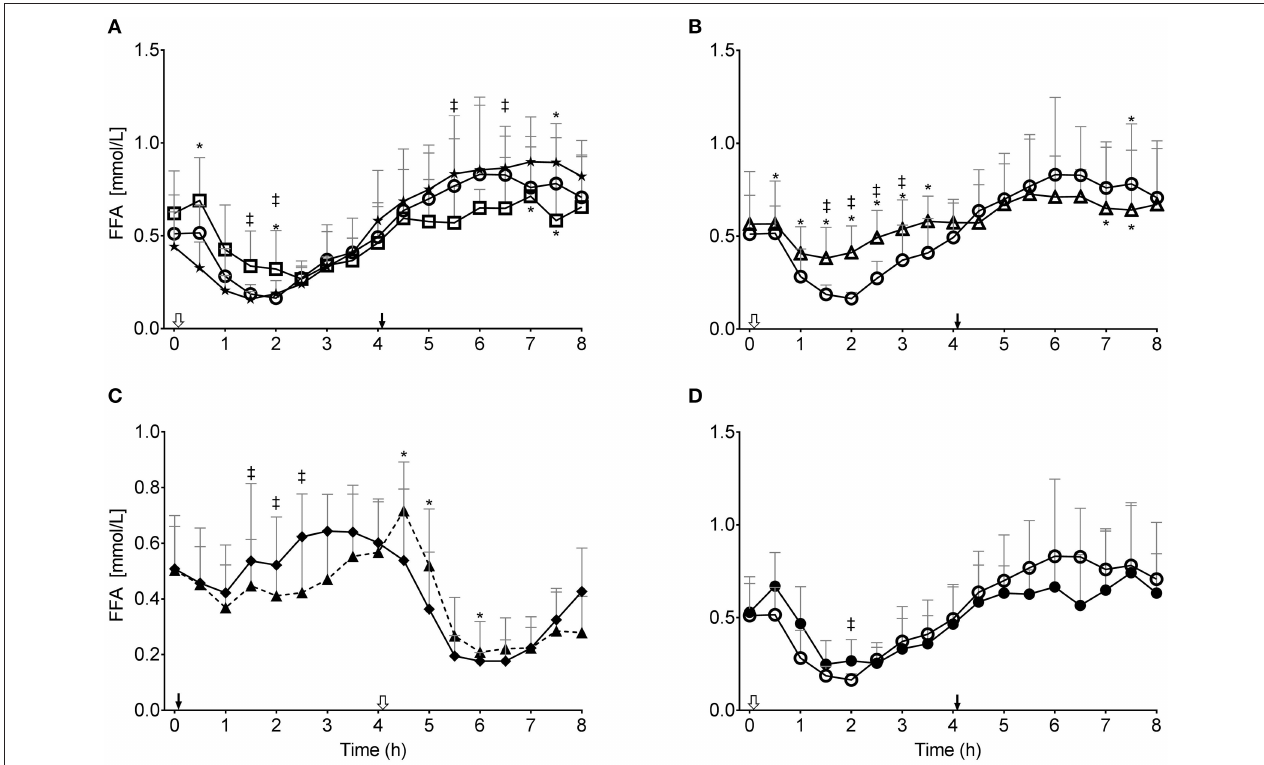
FIGURE 5 | Plasma free fatty acid (FFA) concentration during the tests: (A) without consuming kMCT (CTL, ⋆ ) or after 10g or 20g of kMCT (kMCT10, ; kMCT20, 2 ); (B) after 10g of kMCT with a carbohydrate-rich (kMCT0, ) or low carbohydrate (kMCT10LC, 1 ) meal; (C) after no meal or kMCT at T0 but a meal at T4 (MS-CTL; (cid:7) –– (cid:7) ) or no meal at T0 but a meal plus kMCT10 at T4 (MS-kMCT; N –– N ); (D) Older (•) vs. Young ( ) after kMCT10 at T0. The black arrow indicates when the meal plus kMCT were consumed and the white arrow indicates when kMCT alone was consumed without the accompanying meal. Values are presented as mean ± SD ( n = 6–10). *Difference with CTL; ‡ Difference between the different test conditions ( P < 0.05).